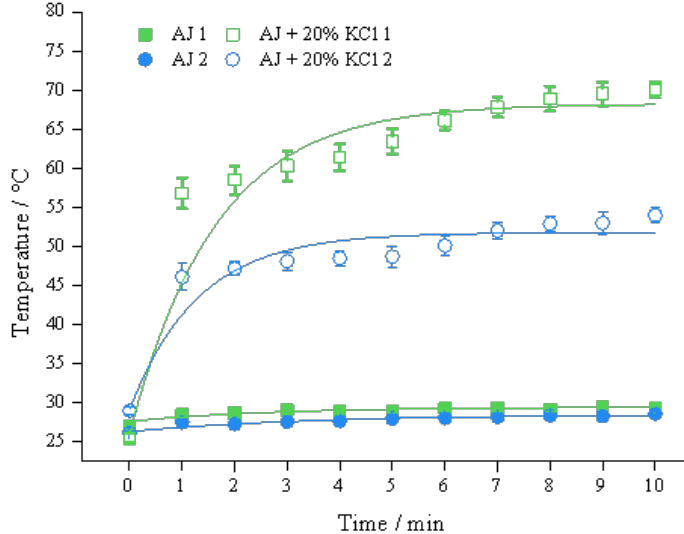
Figure 5. Effects of N tube (number of parallel link tubes) on temperature profile at 800 V, 400 Hz, d 1 = 2 mm, L 1 = 10 cm, N S = 2 × 19.